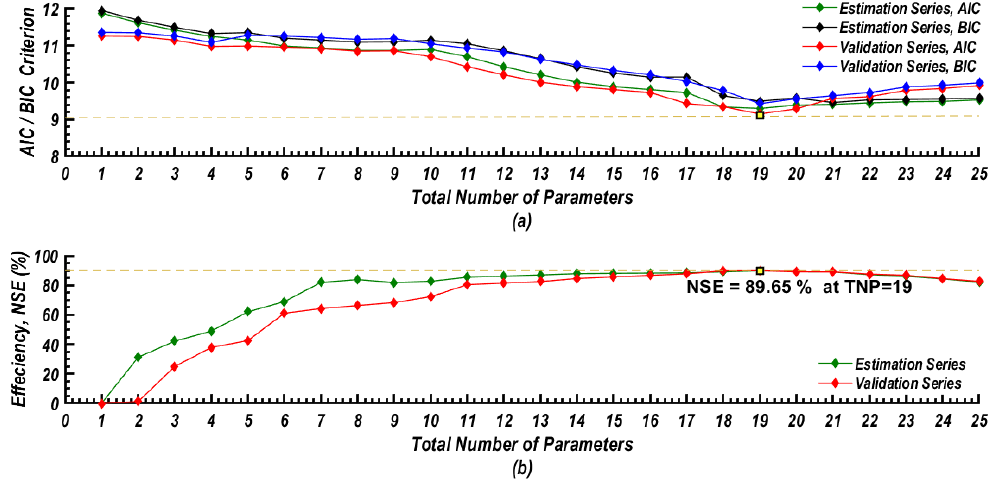
Figure 7. ( a ) Variation of AIC and BIC with the NARMAX total number of parameters. ( b ) Variation of NSE efficiency with the NARMAX total number of parameters.